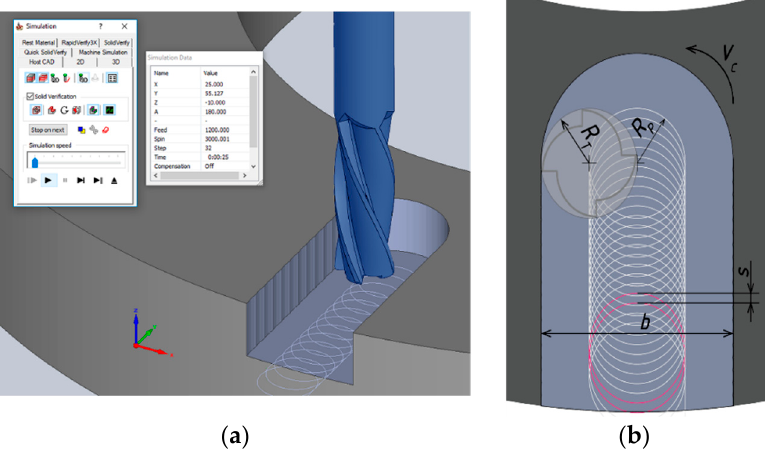
Figure 4. Diagram of the presented method of trochoidal grooving according to SolidCAM: ( a ) presentation of GUI of SolidCAM; ( b ) orthogonal view of trochoidal milling path, where: R T — radius of the milling cutting tool; R P — radius of the trochoid circle; b— width of the milled groove; s— trochoid